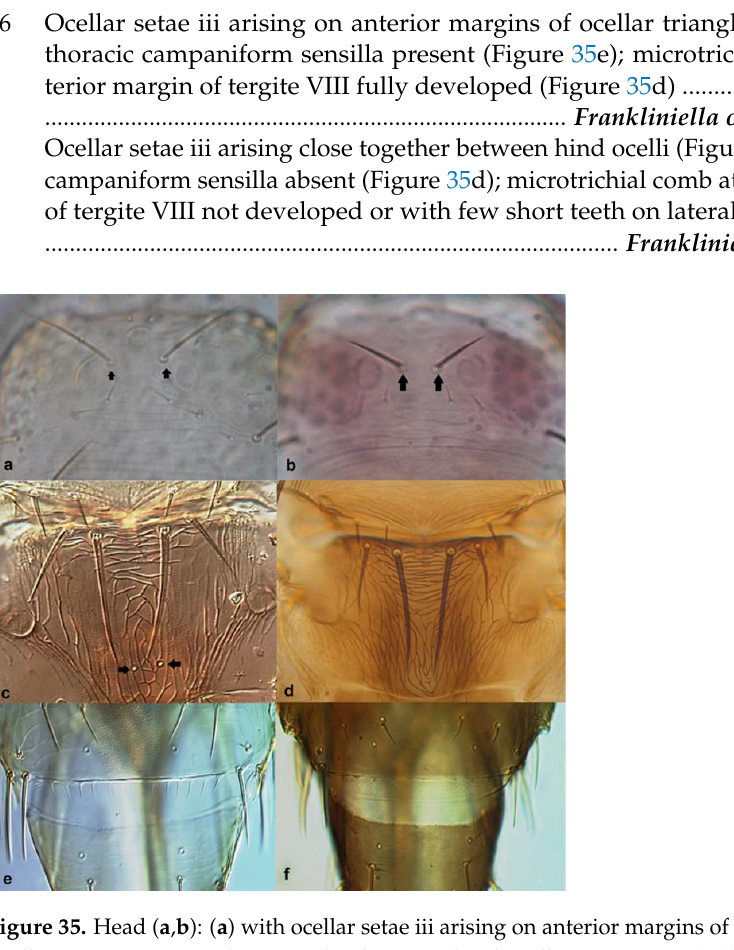
Figure 35. Head ( a , b ): ( a ) with ocellar setae iii arising on anterior margins of ocellar triangle; ( b ) with ocellar setae iii arising close together between hind ocelli; metanotum ( c , d ): ( c ) with campaniform sensilla present; ( d ) with no campaniform sensilla; abdominal tergite VIII ( e , f ): ( e ) with complete microtrichial comb; ( f ) with no microtrichial comb.